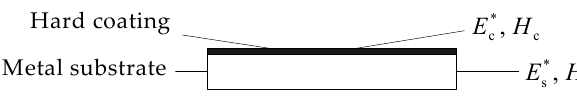
Figure 1. Hard ‐ coating damping composite structure. Figure 1. Hard-coating damping composite